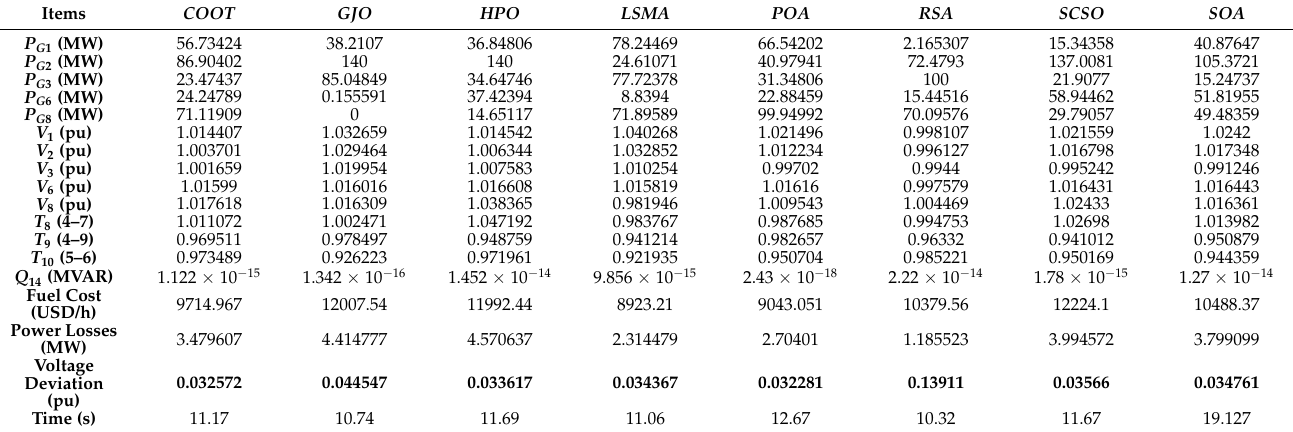
Table 4. Optimal control variables for the IEEE 14-bus test system for minimizing voltage